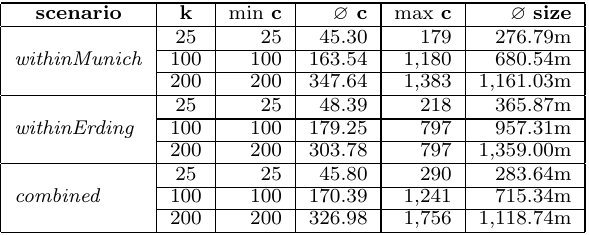
Table 3: Number of buildings and SZ side